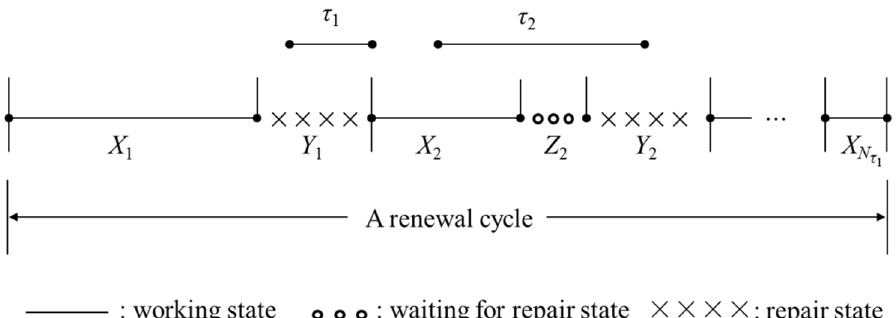
Figure 1. A possible sample path of the system.